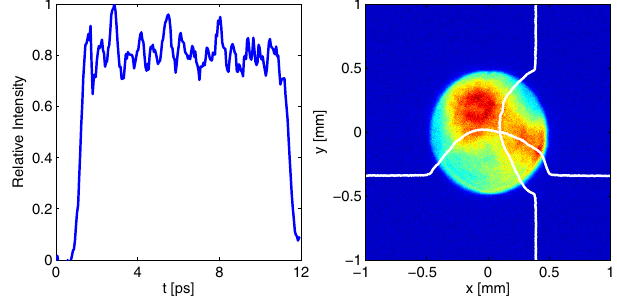
FIG. 11. Left: typical temporal laser profile for a bunch charge of 200 pC. Right: spatial laser profile at the cathode for the measurements done at 200 pC (the white lines are the projections onto the horizontal and vertical axes).